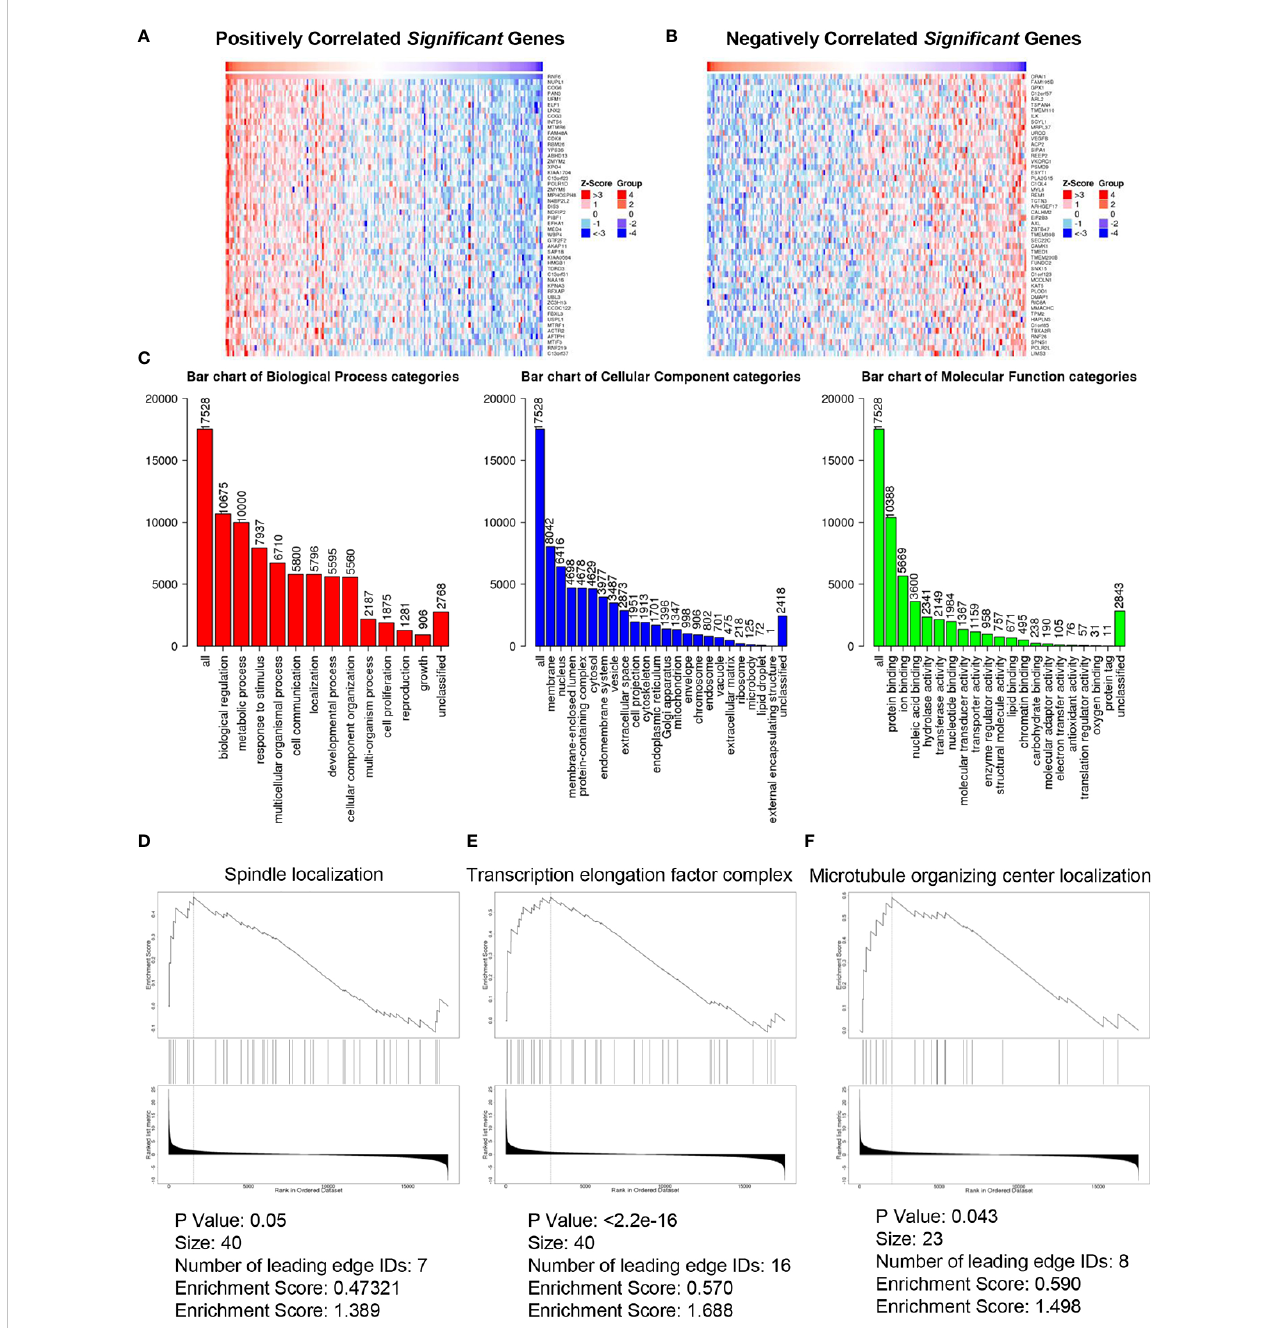
FIGURE 4 Co-expressed genes and functional enrichment analysis of RNF6 in esophageal cancer. (A) Heatmap analysis of genes that are positively correlated with RNF6 co-expression. (B) Heatmap analysis of negatively correlated genes with RNF6 co-expression. (C) Functional enrichment analysis of RNF6 co- expression. (D – F) . RNF6 co-expressed genes affect Spindle localization, Transcription elongation factor complex and Microtubule organizing center localization in esophageal cancer